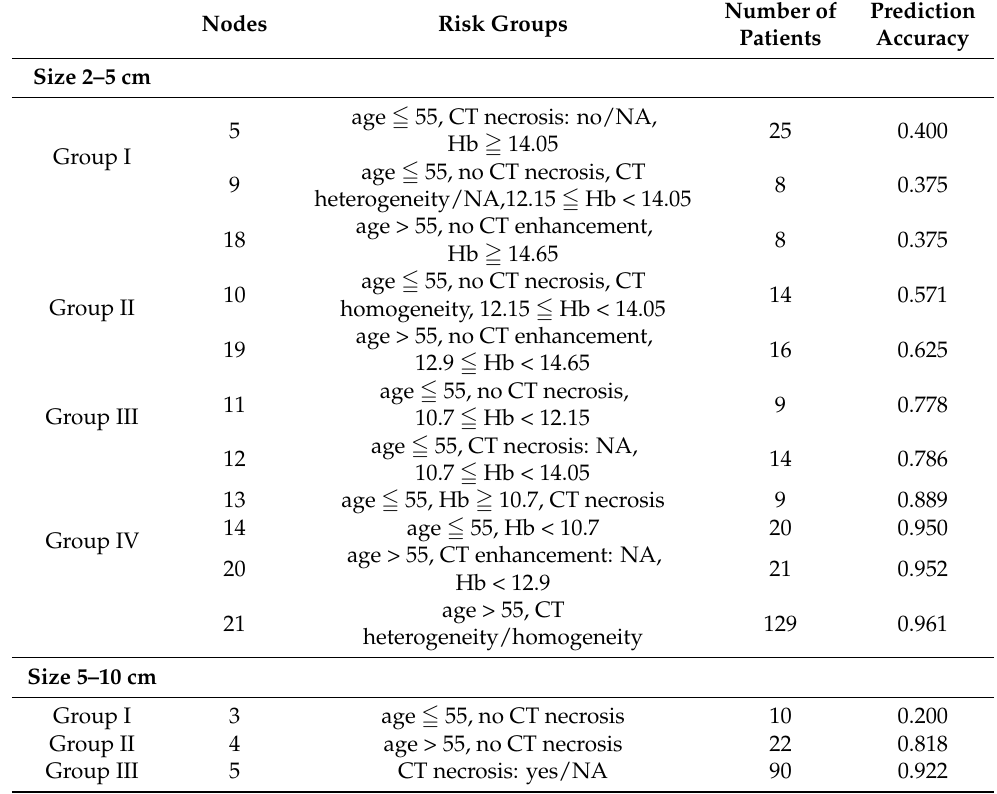
Table 3. Risk classification according to the results of the recursive partitioning analysis. Nodes Risk Groups